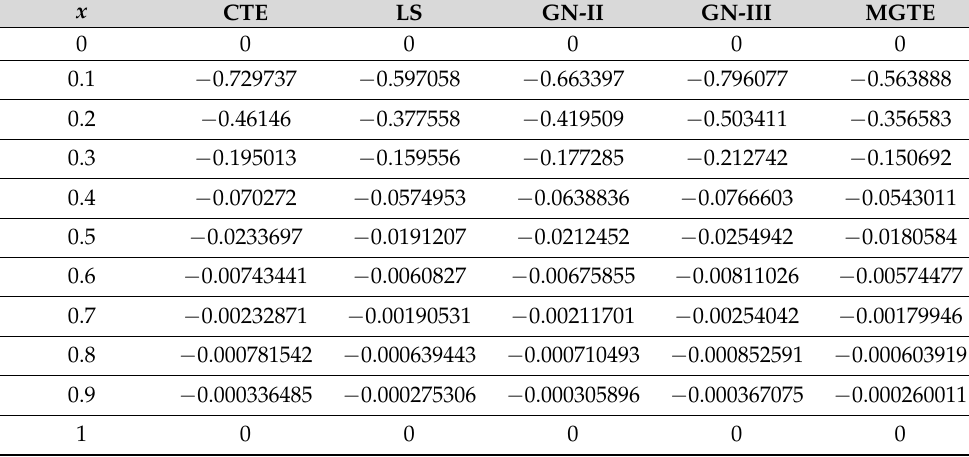
Table 2. The thermal deflection w versus thermoelastic models.